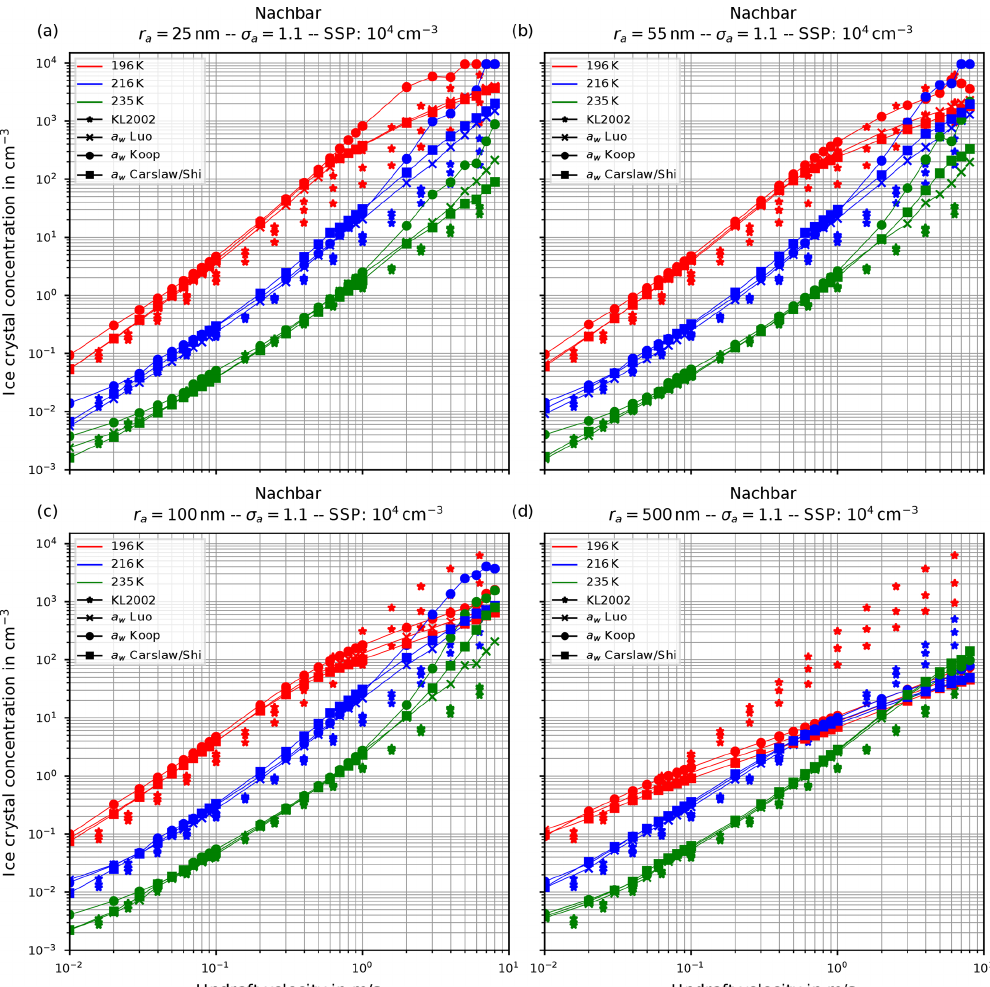
Figure 8. Fixing Nachbar’s parameterization p sat , Nach for the saturation vapor pressure. The panels show the influence of increasing the geometrical radius r a of the lognormal size distribution for the dry aerosol (indicated in the title of each panel) on the number of nucleated ice crystals by keeping the geometrical width σ a = 1 . 1 constant; the format of the panels is as in Fig.